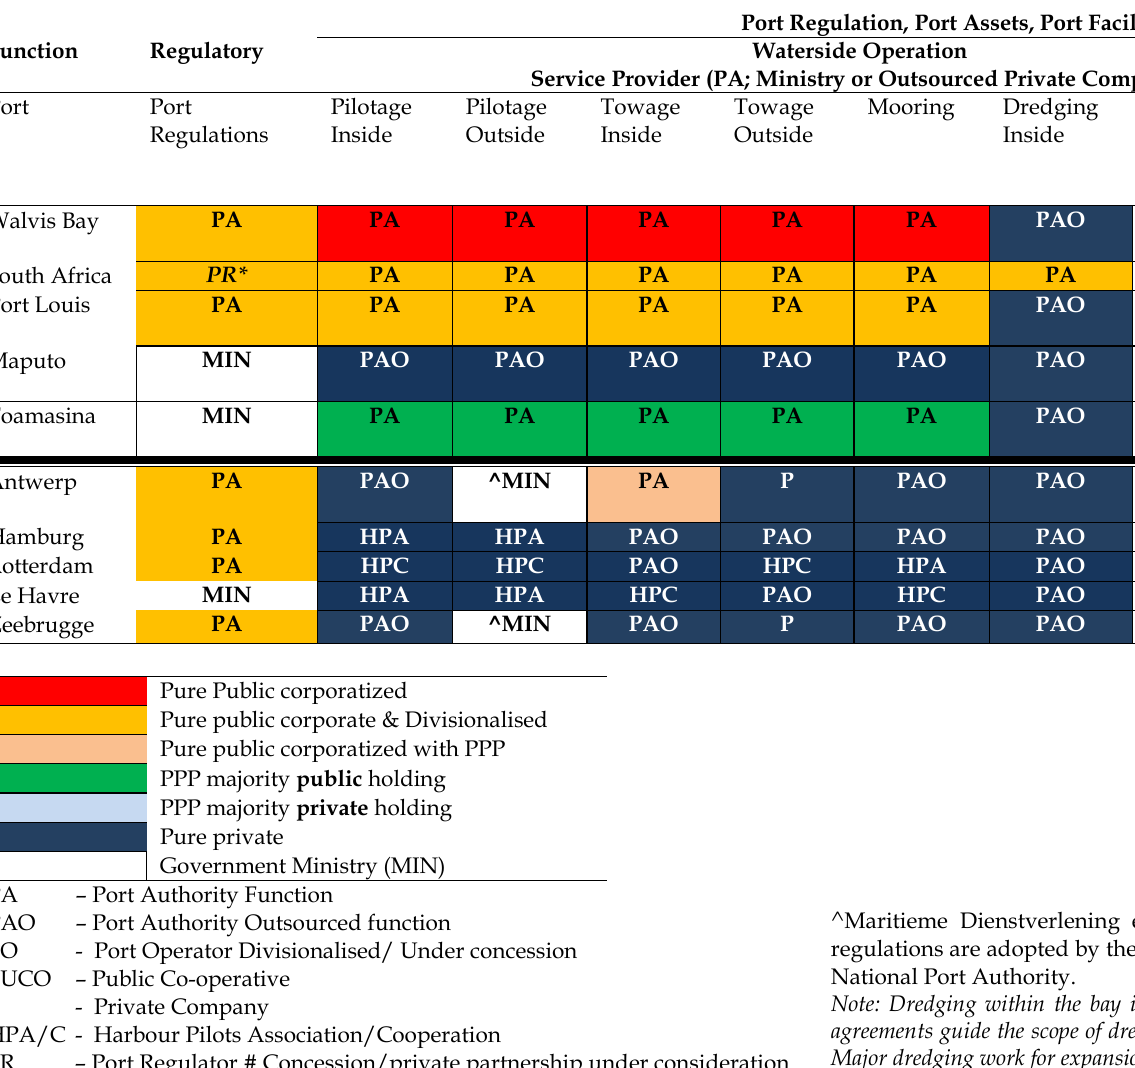
Table 6. Southern African & Northern European Port Functional